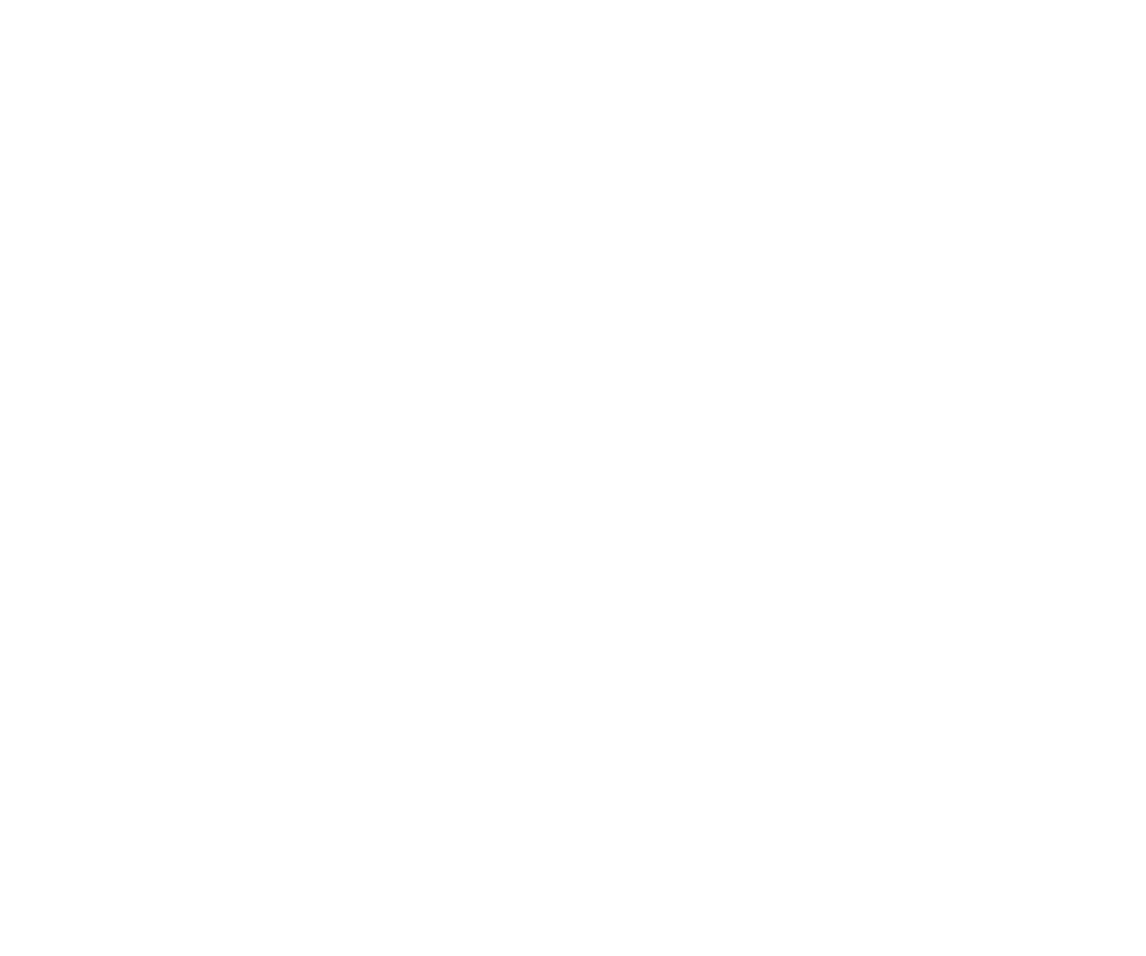
Table 5. Wilcoxon signed rank tests: Jaya vs. SJaya on the 12-function benchmark suite. Metric #zero Diff. Mean of Best-of-Run